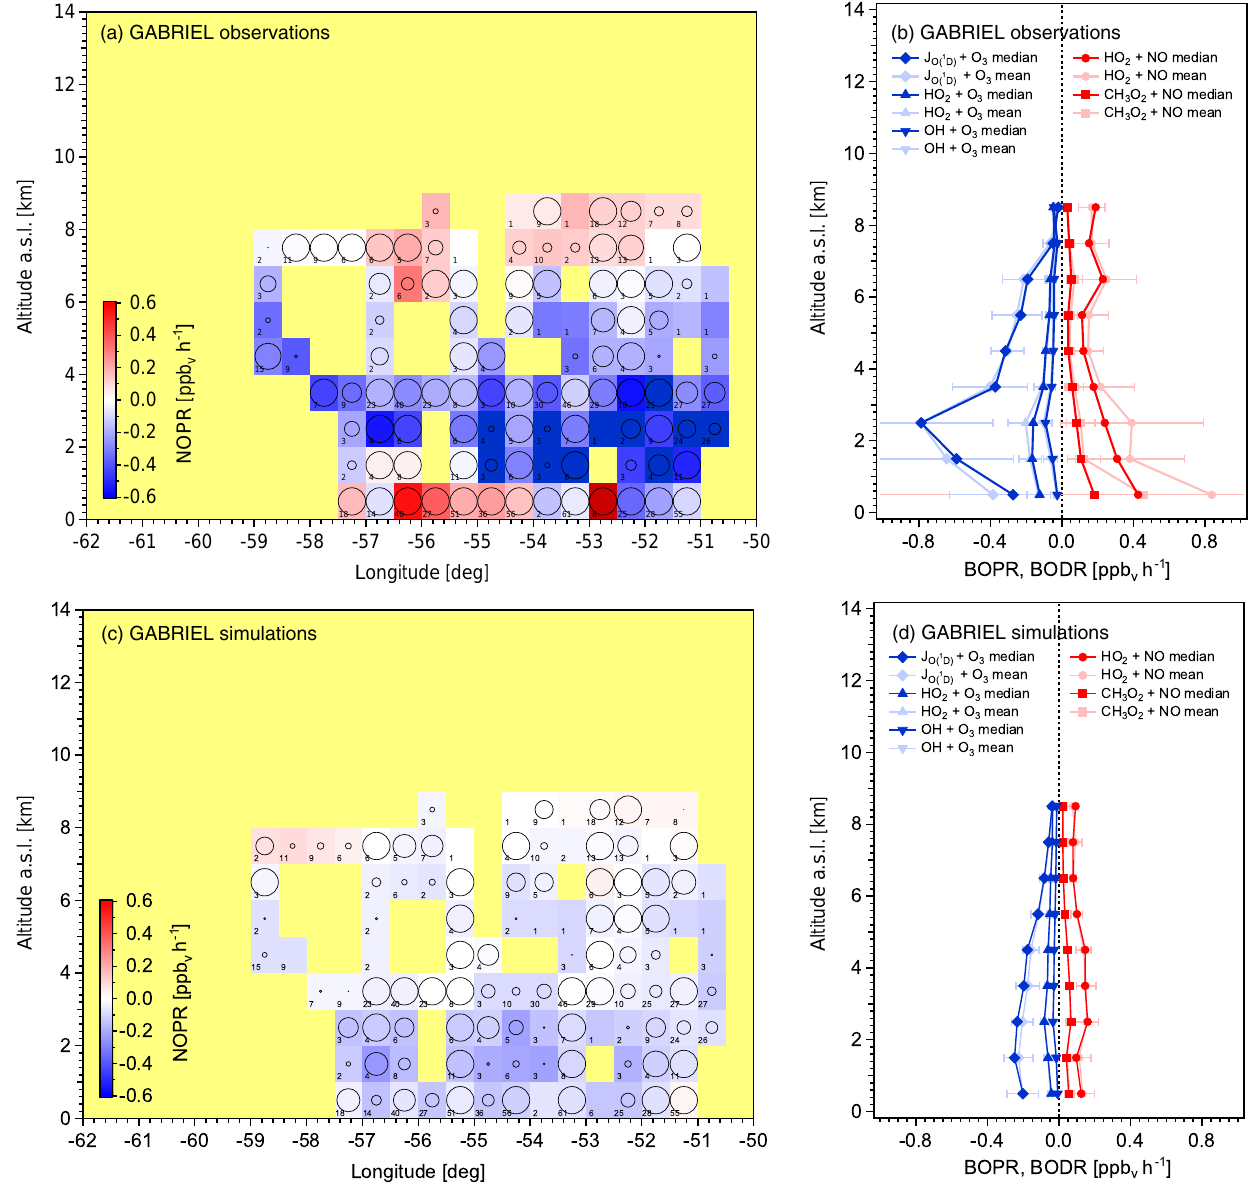
Figure 2. Net ozone production rates (NOPR) in ppbvh − 1 calculated from in situ data (a) and from MATCH simulations (c) for GABRIEL. Altitude profiles of individual production and destruction rates are shown in panels (b) (observations) and (d) (model